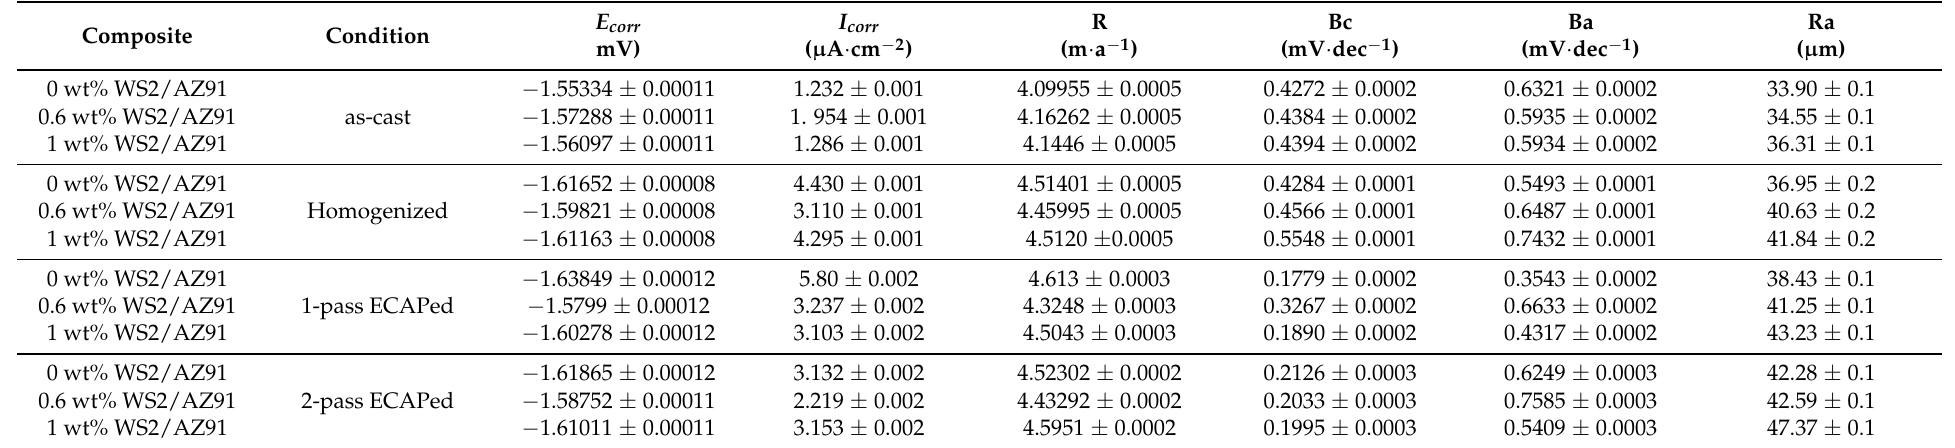
Table 1. Summary of corrosion parameters for WS 2 /AZ91